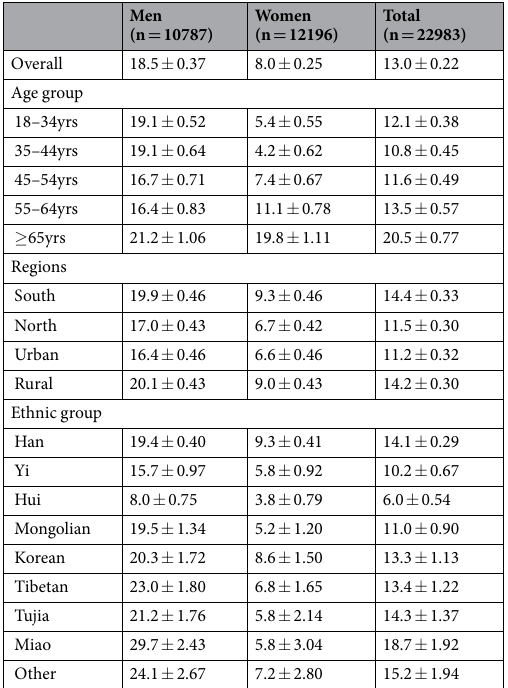
Table 1. Prevalence of hyperuricemia among study population. Data are presented as percent prevalence ± standard